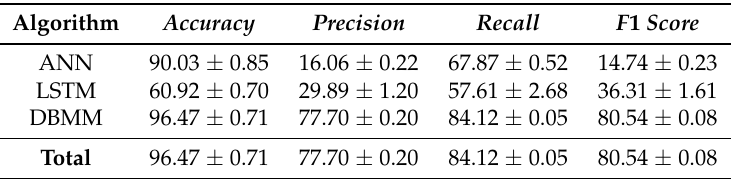
Table 12. Global evaluation metrics: ANN vs LSTM vs